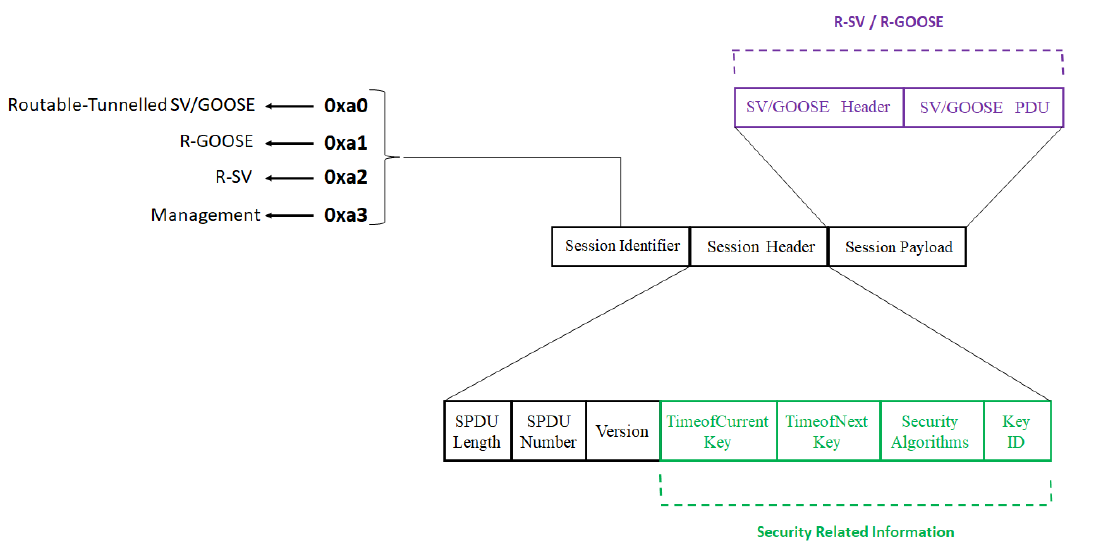
Figure 10. IEC61850-90-5 session protocol — security related information in the session header.